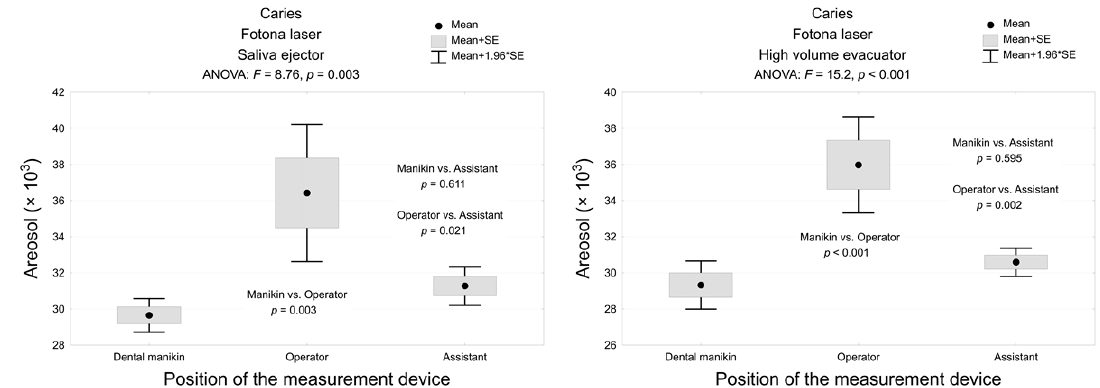
Figure 6. The amount of the dental spray during caries removal with Er:YAG laser with a high volume evacuator or saliva ejector, measured in 3 areas and the analysis of variance and post-hoc test (multiple comparisons using the Tukey test).